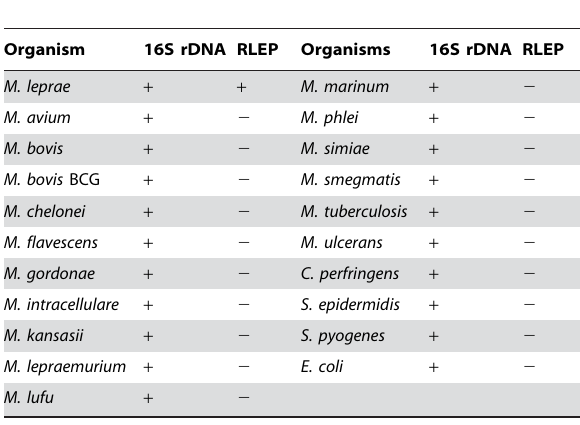
Table 1. Specificity of RLEP TaqMan for Mycobacterium leprae